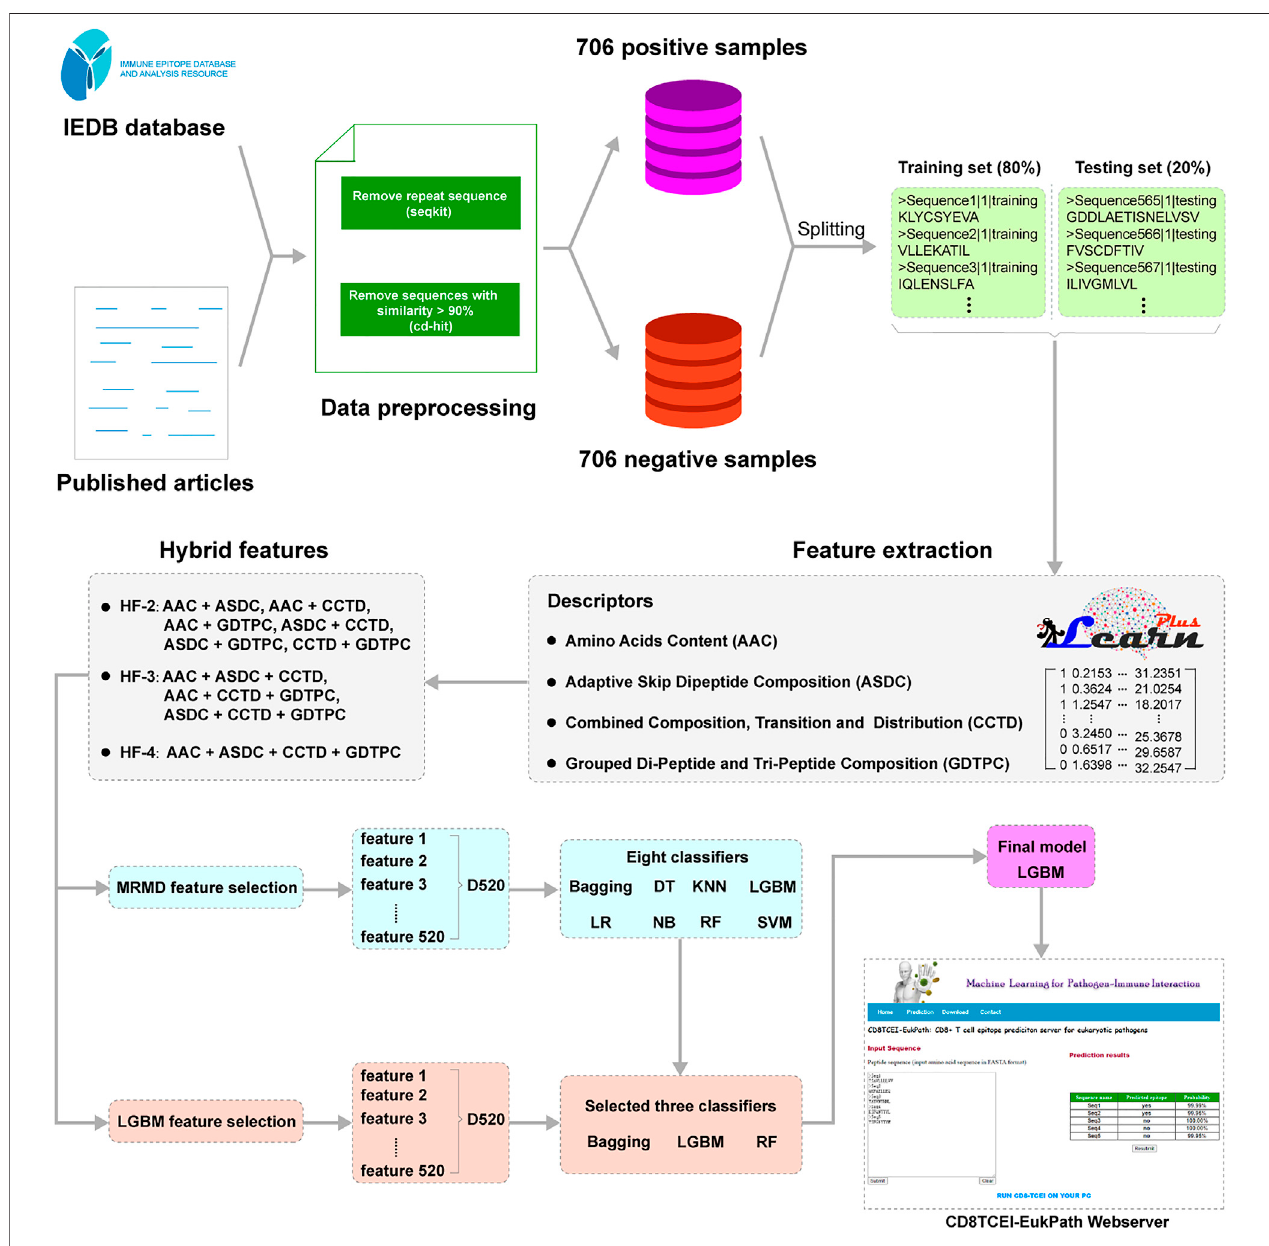
FIGURE 1 | A technology roadmap of the machine learning model proposed in this